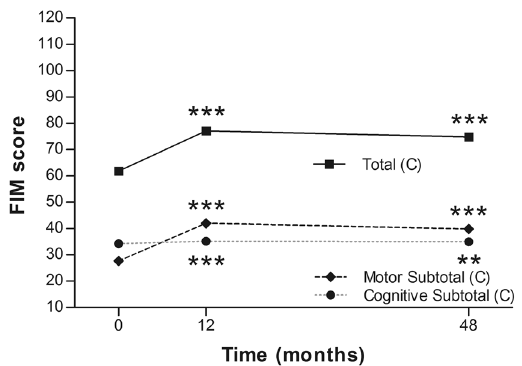
Figure 5. Mean Functional Independence Measure of the cervical group at each time point. ** p < 0.005; *** p <